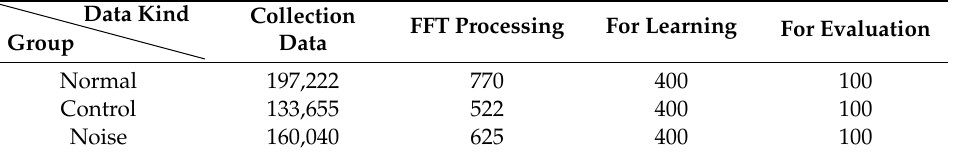
Table 3. ECG data usage